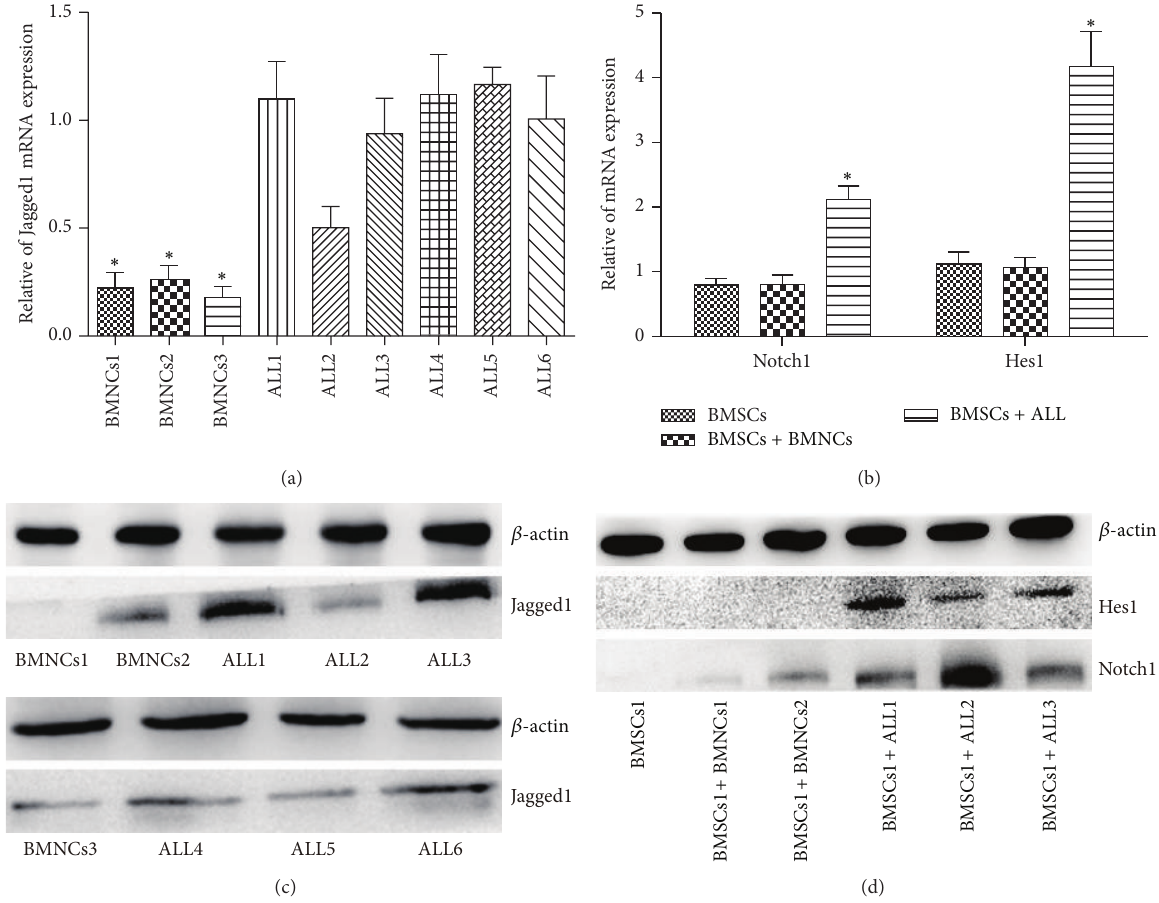
Figure 2: ALL cells activate Notch signaling in BMSCs in coculture. (a), (c) The Jagged1 expression levels in ALL cells and normal BMNCs were evaluated by real-time RT-PCR and western blotting ( ∗ 𝑃 < 0.05 versus BMNCs). (b), (d) The mRNA and protein expression levels of Notch1 and Hes1 in BMSCs were analyzed using real-time RT-PCR and western blot analysis after 3-day cocultured with ALL cells or BMNCs ( ∗ 𝑃 < 0.05 versus BMSCs cultured alone or coculture with